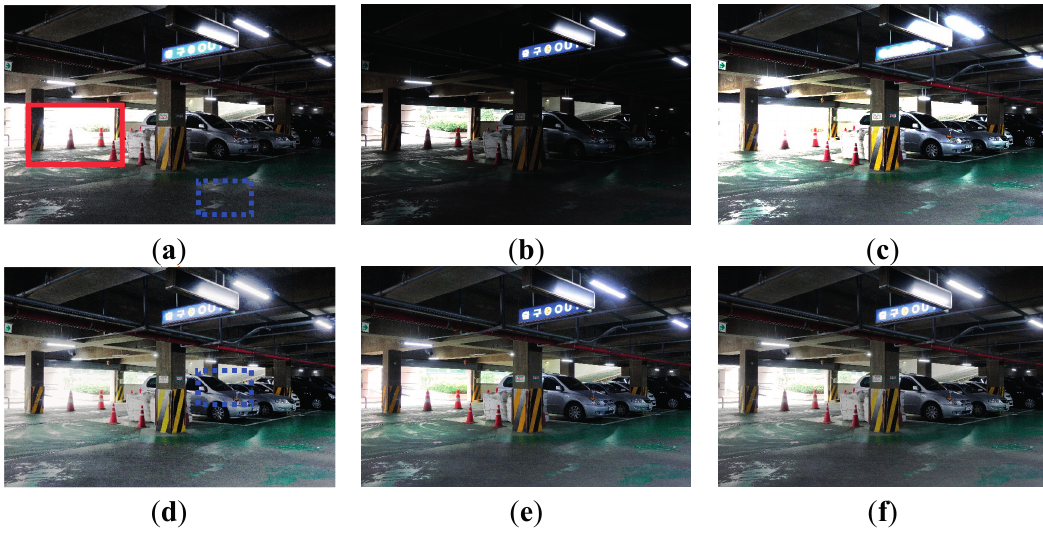
Figure 8. Experimental results using the parking garage image: ( a ) The reference image with ISO 3200 (EV = +1); ( b ) one-step lower image using ISO 800 (EV = − 1); ( c ) enhanced image of (b) using ordinary four-pixel digital pixel binning; ( d ) enhanced image of (b) using Kim’s algorithm; ( e ) enhanced image of (b) using Jiang’s algorithm; and ( f ) enhanced image of (b) using the adaptive four-pixel digital pixel binning